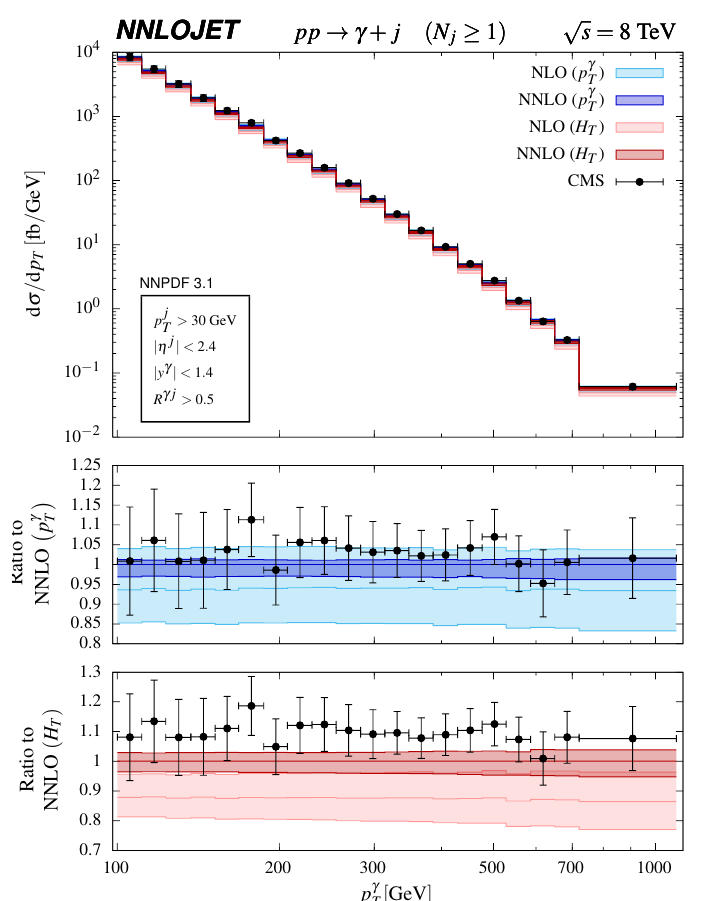
Figure 9 . Transverse energy/momentum distribution of the photon at NLO and NNLO for di(cid:11)erent central scale choices: p (cid:13) in blue, H T in red. The calculations are carried out using the NNPDF3.1 T NNLO PDF set [60] and the hybrid isolation procedure. The results are compared to 8 TeV CMS data